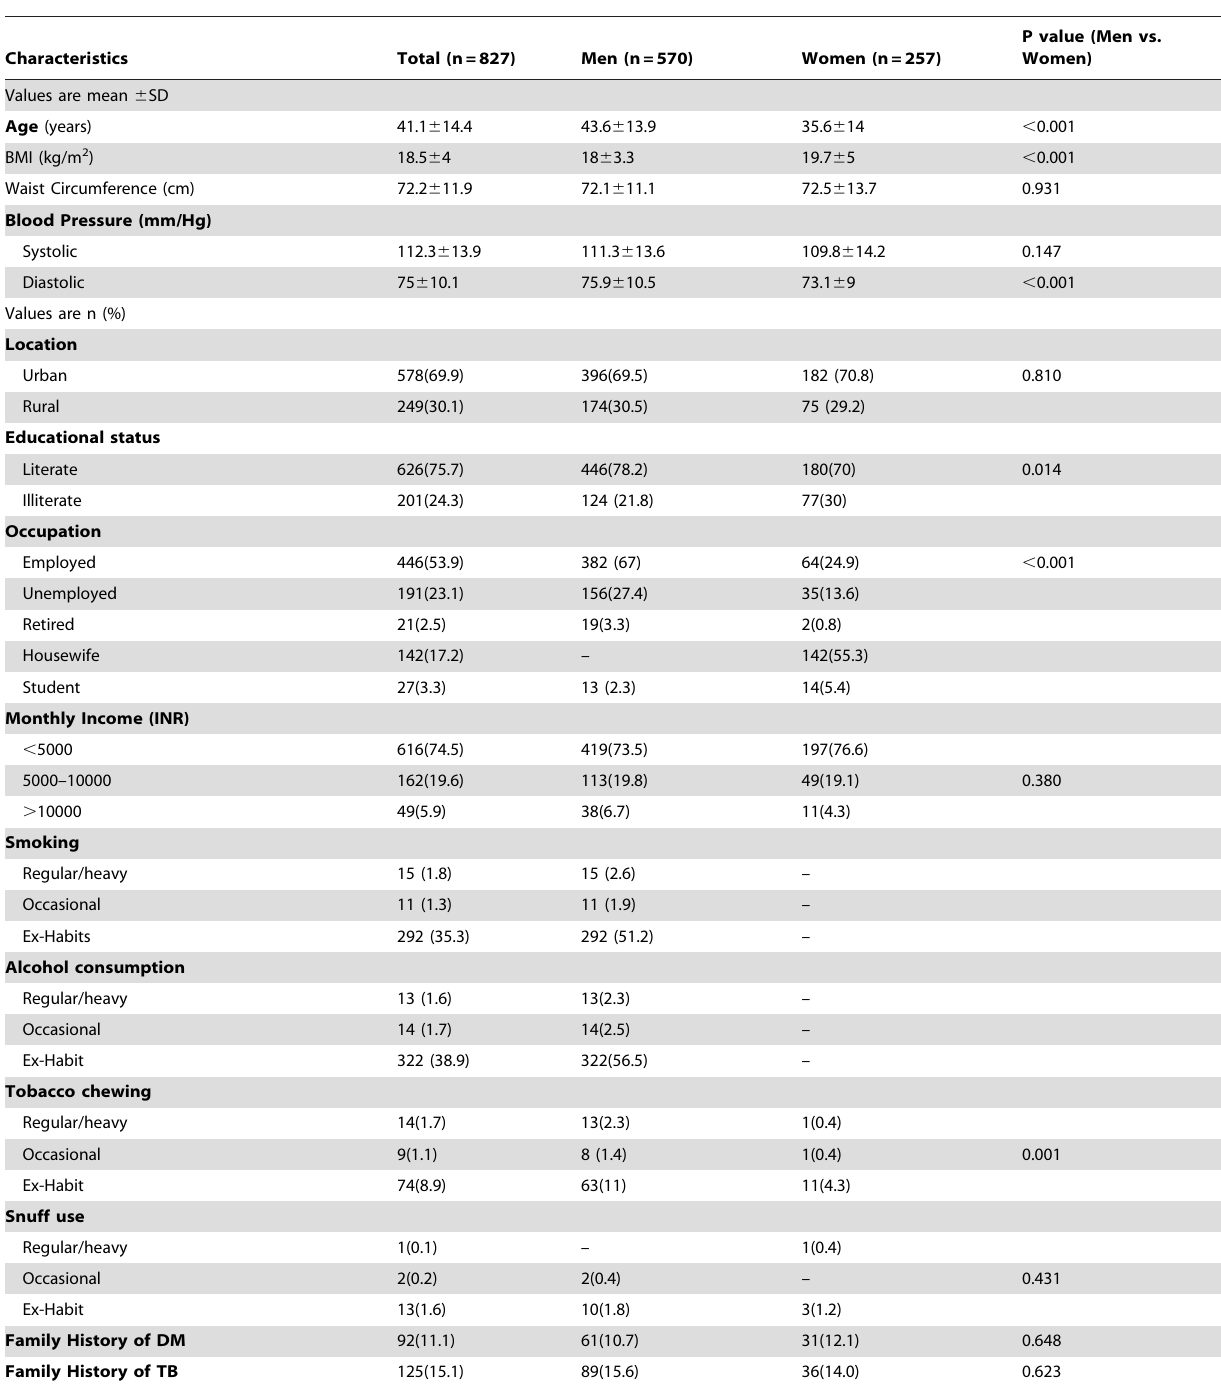
Table 1. Demographic and anthropometric details of the study subjects.